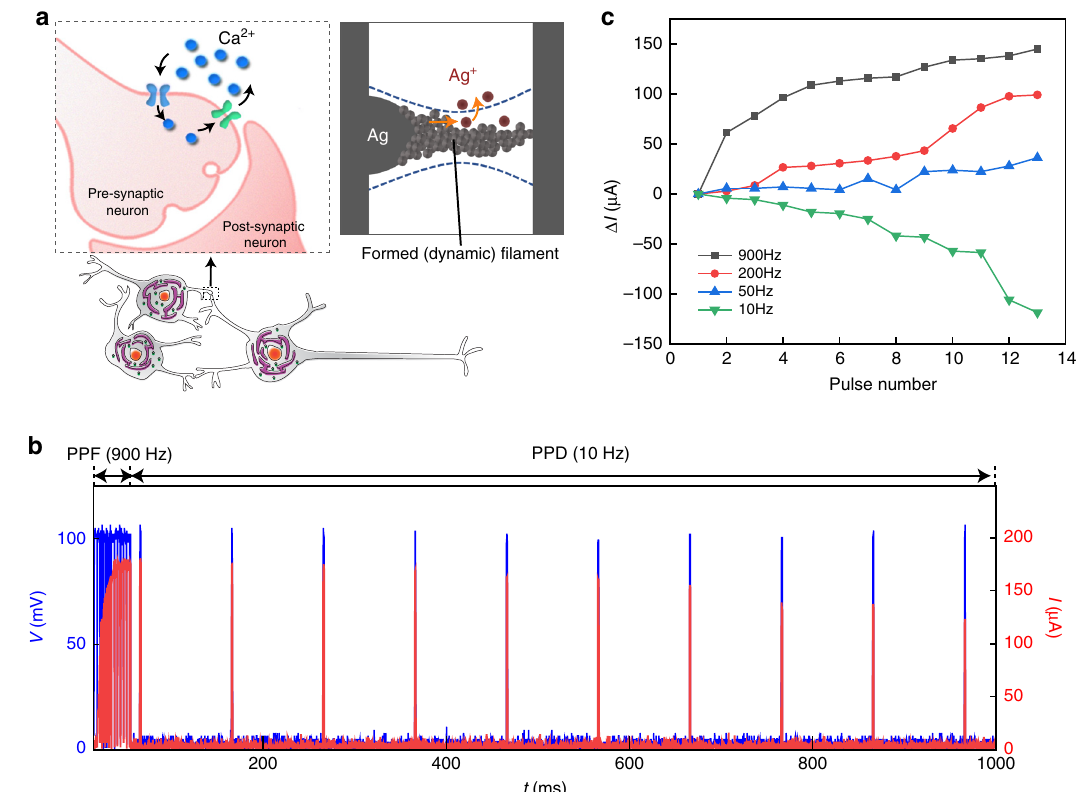
Fig. 5 Protein nanowire arti fi cial synapse. a (Left schematic) Ca 2 + in fl ux and extrusion in a biosynapse that underlies synaptic plasticity. (Right schematic) The increase (by anodic injection) or decrease (by diffusion) of Ag atoms in a formed fi lament can lead to the dynamic increase or decrease in fi lament size. The resultant conductance change can mimic the synaptic plasticity. b Conductance modulation in an activated protein nanowire memristor by modulating the frequency in inputs (100 mV, 1 ms). Paired-pulse facilitation (PPF) featuring continuous conductance increase was observed at high frequency (900 Hz), whereas paired-pulse depression (PPD) featuring continuous conductance decrease was observed at low frequency (10 Hz). c Conductance modulation in a protein nanowire memristor with different input